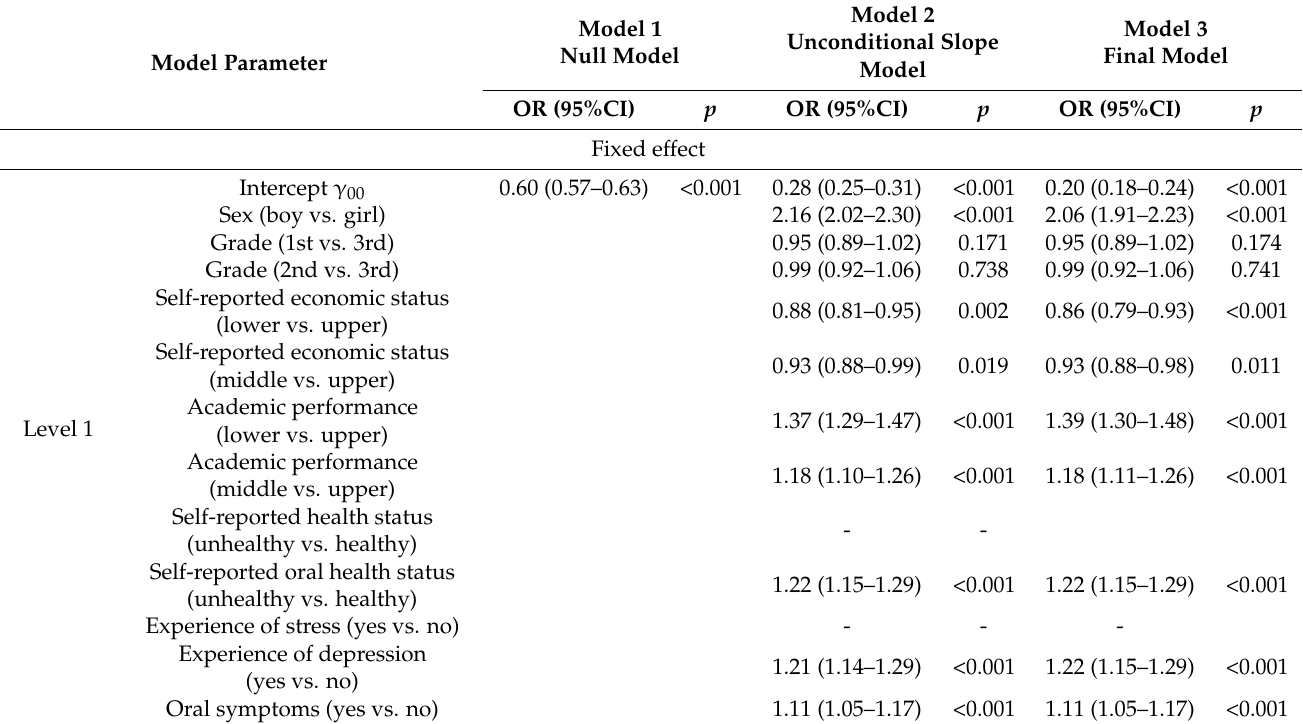
Table 4. Multilevel analysis of students’ soda intake (more than three times a